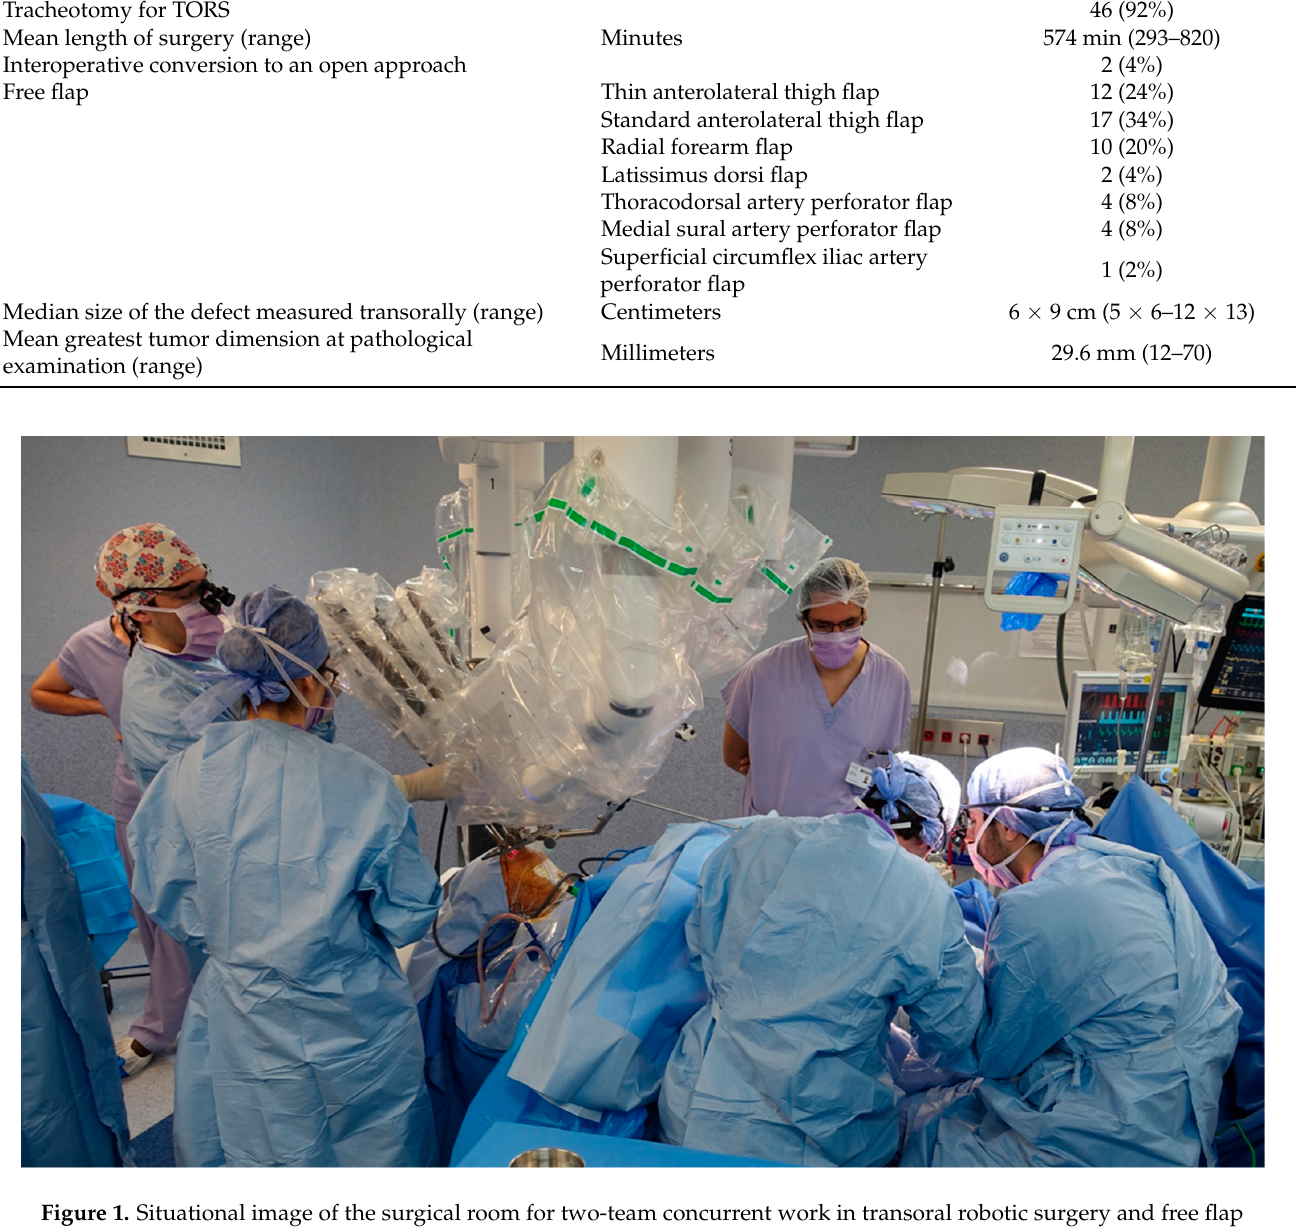
Table 2. Surgical characteristics of the first 50 patients who underwent transoral robotic surgery and a free flap reconstruction at our institution. Surgery Data